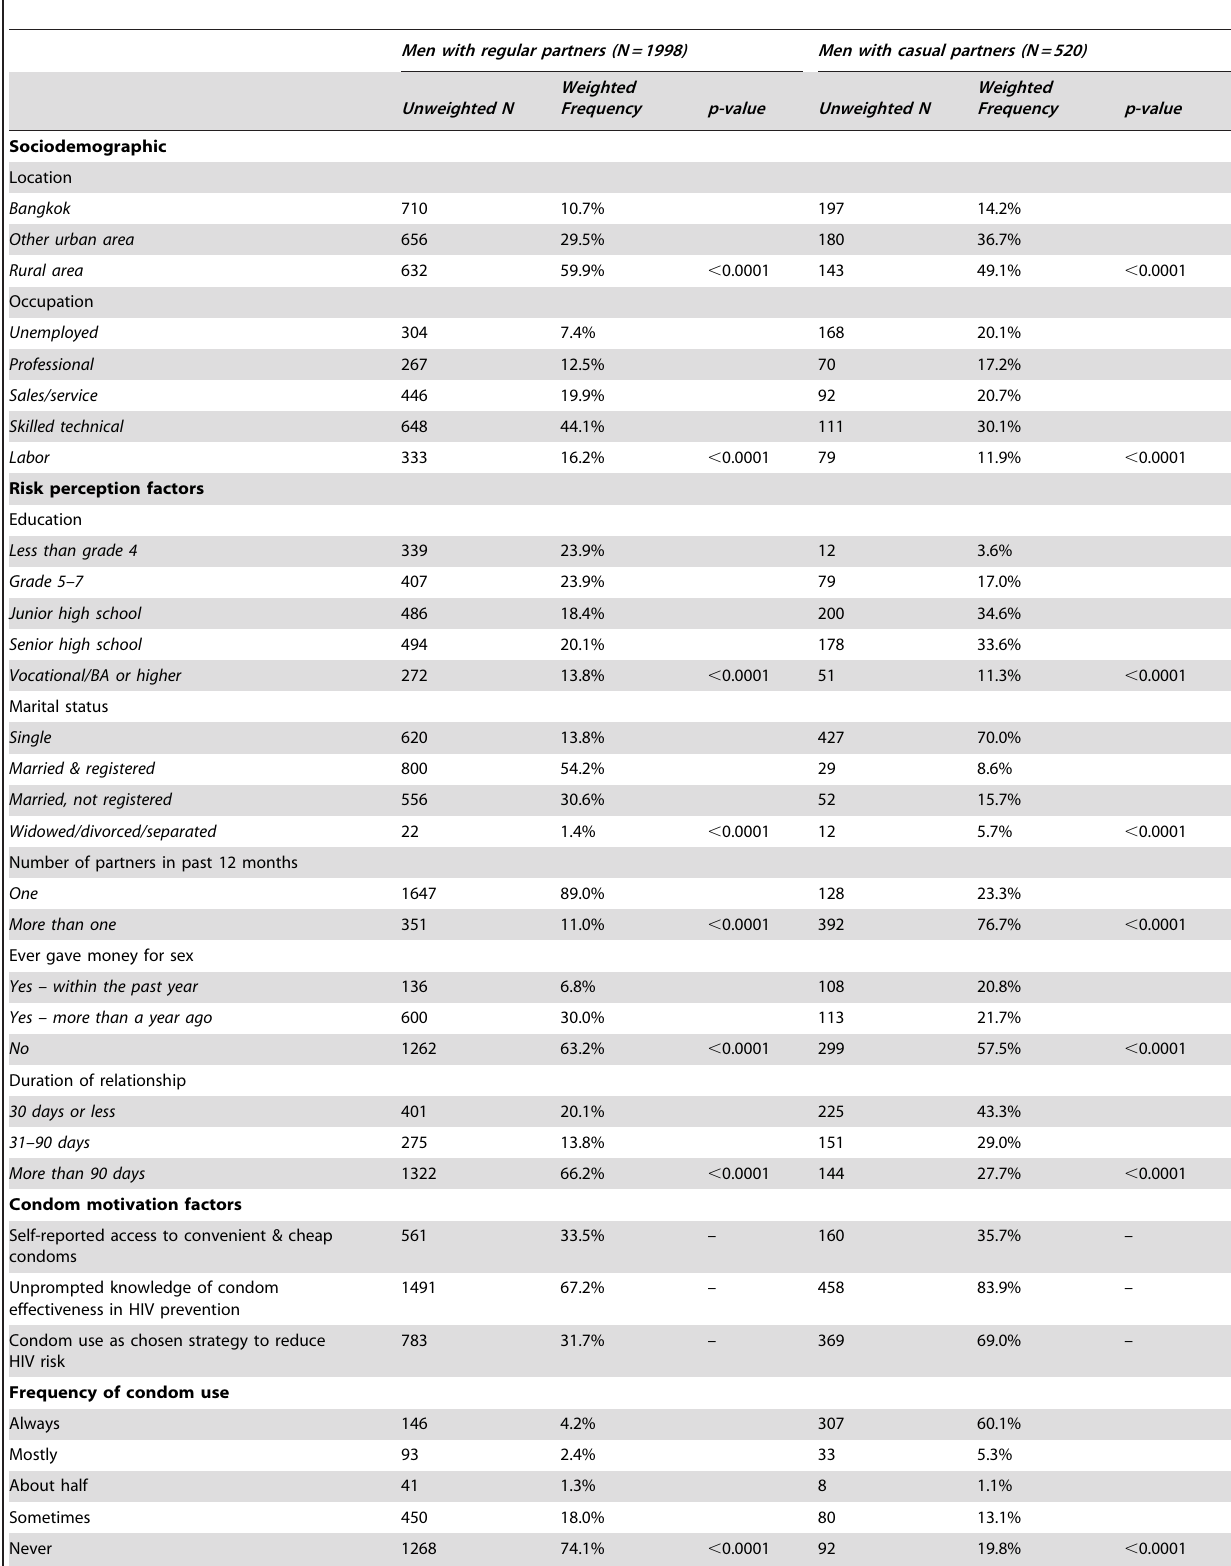
Table 1. Characteristics of study population: men with at least one regular or casual sex partner in the past 12 months in 2006 the National Sexual Behavior Survey of Thailand (N